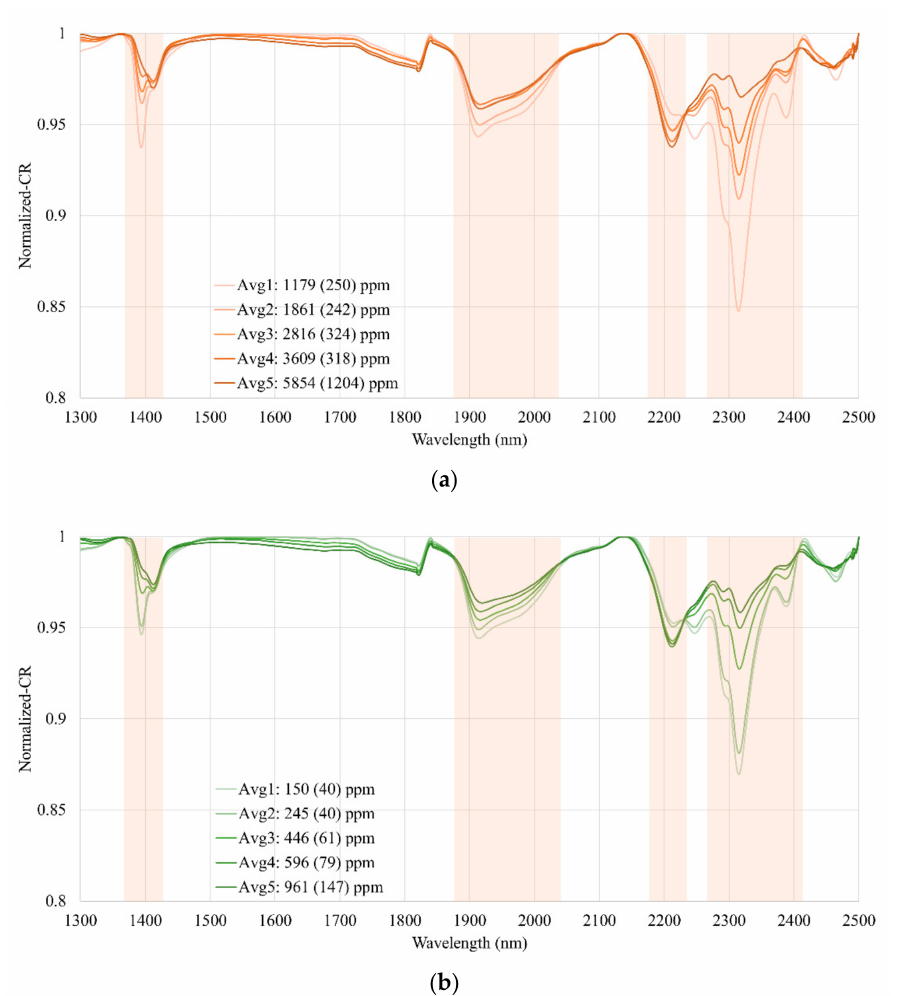
Figure 5. Continuum-removed reflectance spectra of tailing samples at 5 levels of ( a ) As and ( b ) Pb concentration showing systematic variations in absorption depths in the SWIR